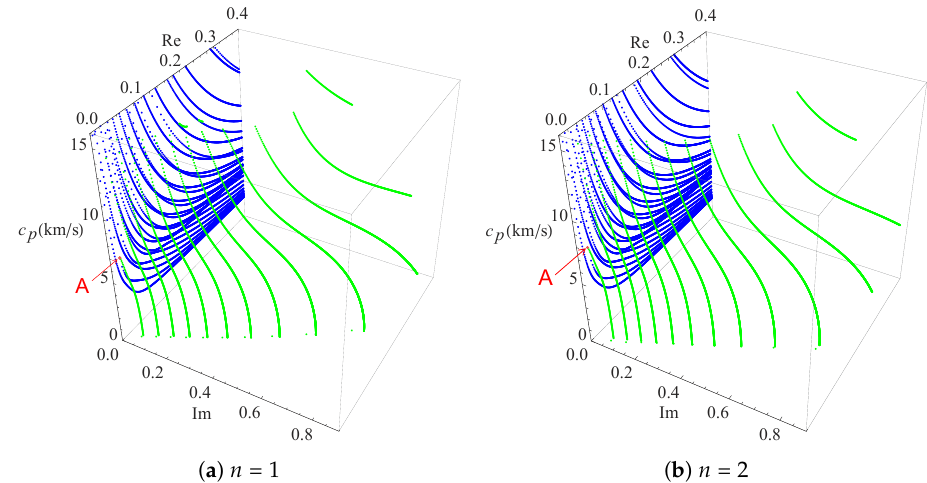
Figure 6. Phase velocity curves of complex Rayleigh waves with different gradient coefficient n in FGPM